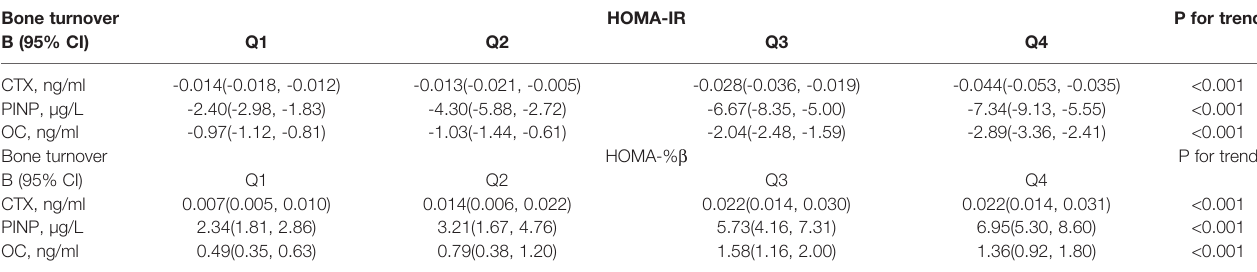
TABLE 2 | The description table for Figure 2